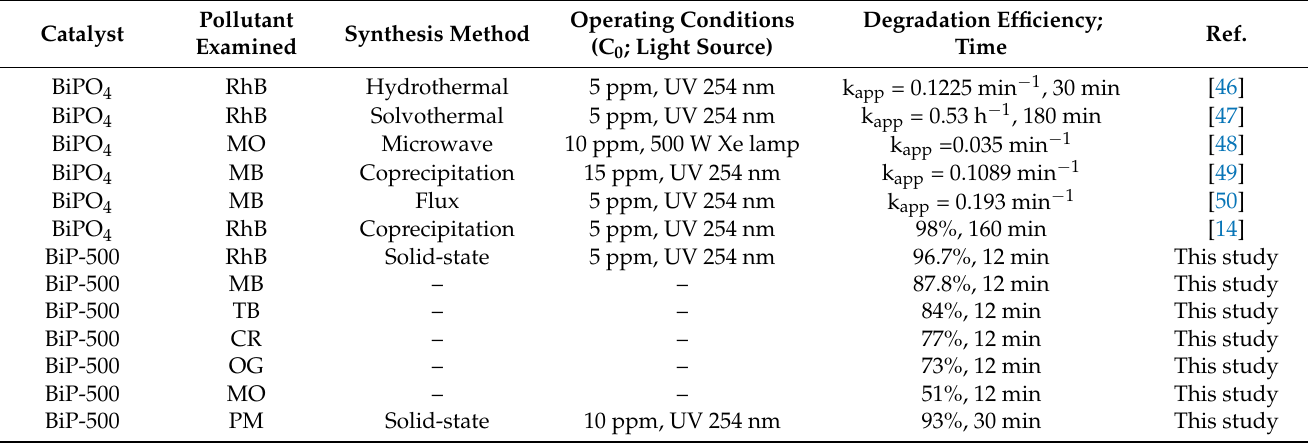
Table 3. Comparison of the photocatalytic activity of the BiP-500 catalyst with other reported